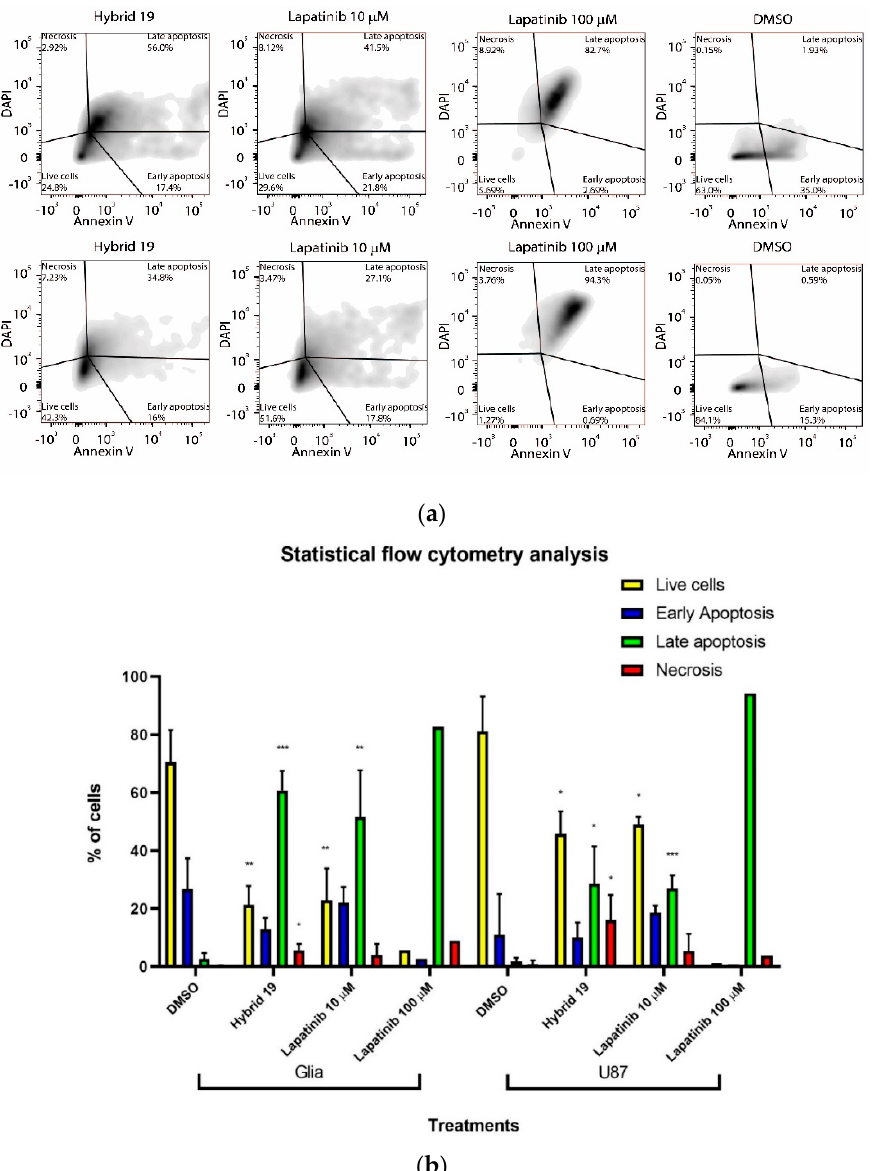
Figure 3. ( a ) Representative examples of phosphatidylserine exposure results for primary glial cells (upper panels) and U87 MG (lower panels). Co-cultures were incubated with hybrid 19 or Lap for 24 h; ( b ) The graphs show the quantitative analysis flow cytometry (three independent experiments). (*) p < 0.05; (**) p < 0.01; (***) p <